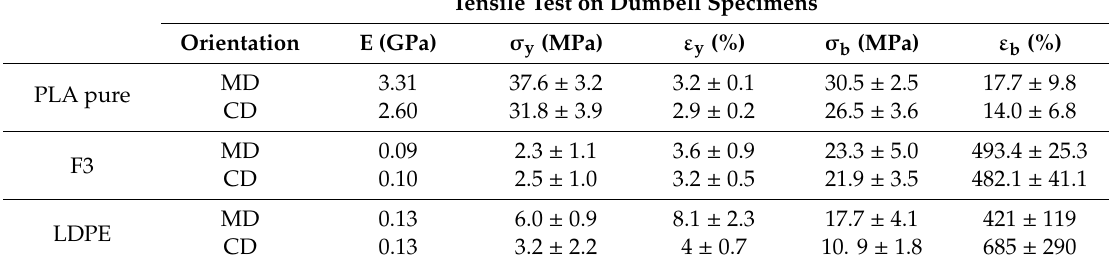
Table 8. Comparison in mechanical properties of PLA, F3 and low density polyethylene (LDPE) extruded films.